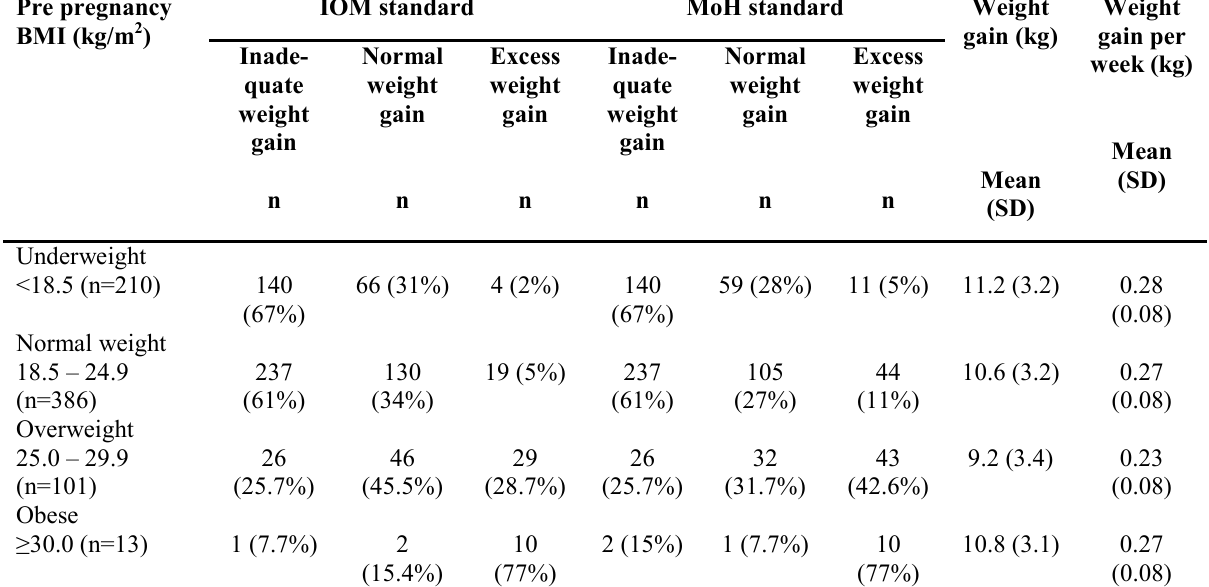
Table 2 – Gestational weight gain pattern in the total sample IOM and Ministry of Health (MoH) standard, by